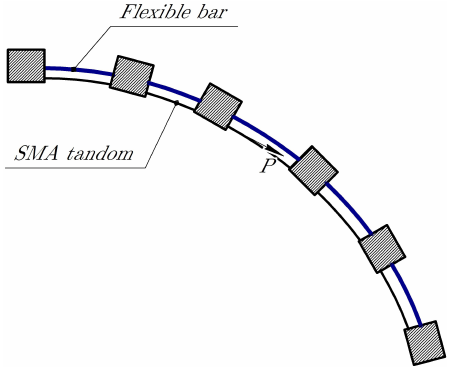
Figure 1. SMA-actuated flexible bar system.